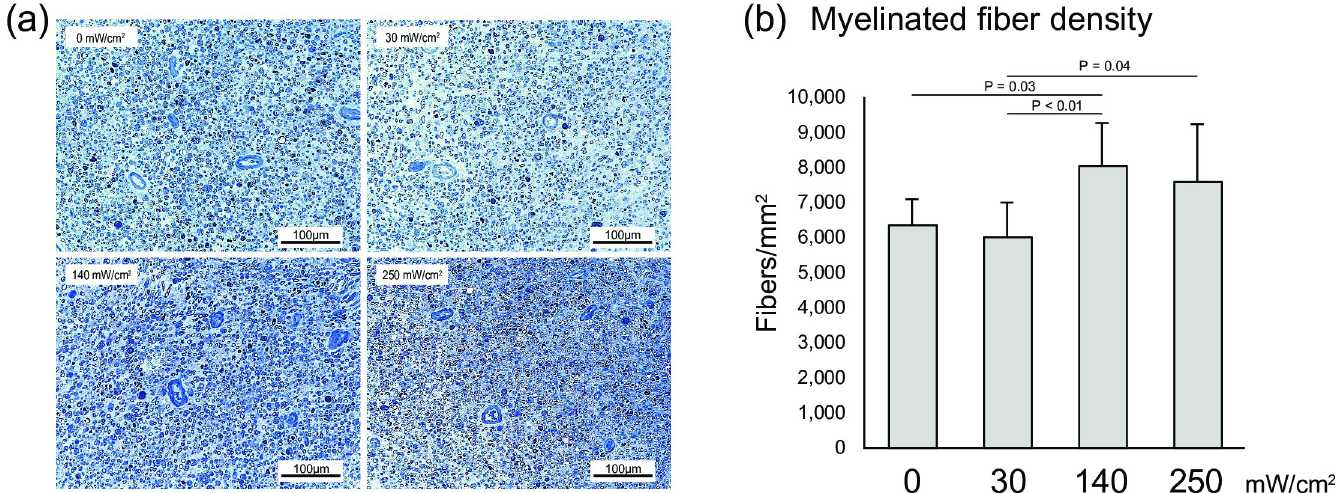
Fig 2. Myelinated fiber density. (a) Representative images of the sections stained with toluidine blue. (b) Mean myelinated fiber density. All data are presented as mean ± SD (n = 9).